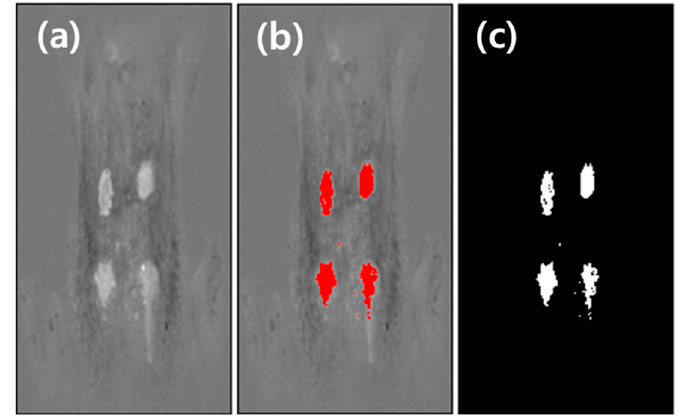
Figure 10. Threshold algorithms with PC2 image using ImageJ. PC2 image ( a ) was applied to determine the threshold value (155) using the Huang method. The threshold employed to the PC2 image ( b ) and its binary image ( c ).